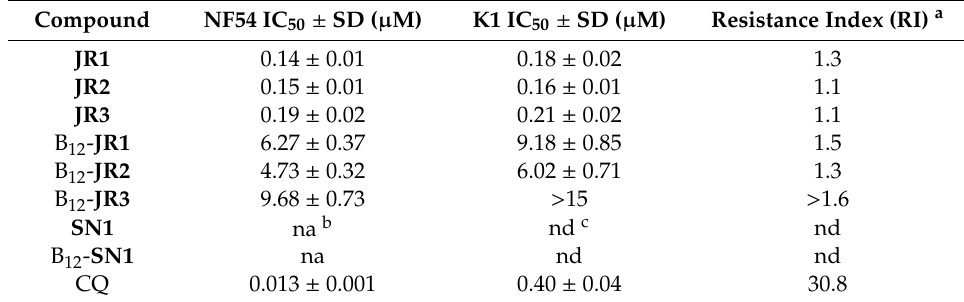
Table 1. Antiplasmodial activity of molecules against the chloroquine-sensitive (CQS) NF54 and chloroquine-resistant (CQR) K1 strains of Plasmodium falciparum .